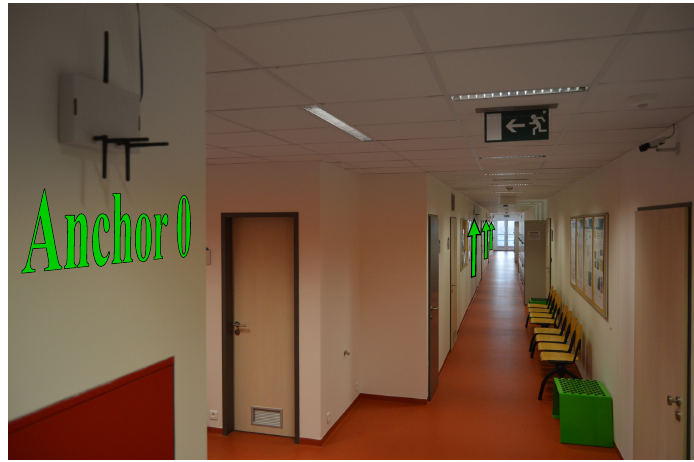
Figure 4. The installed anchors [12]. The photo is taken from the marked position (red camera in Figure 3), Anchor 0 and green arrows indicate anchors’